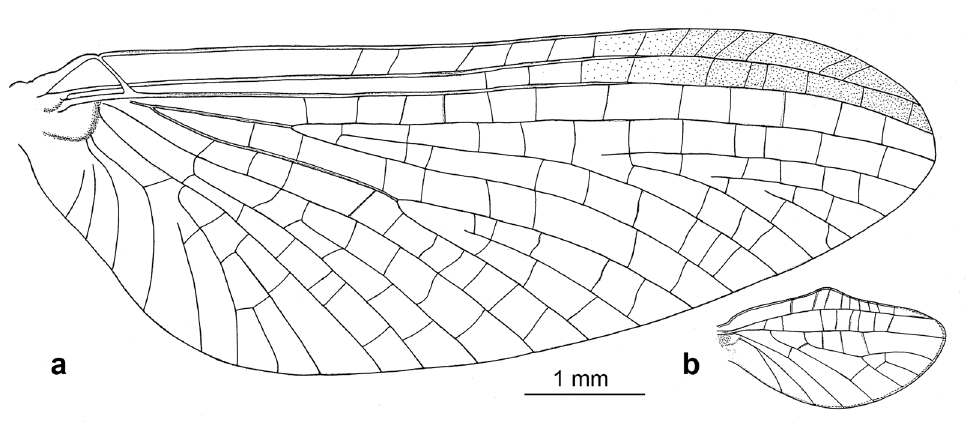
Figure 8. Calliarcys van Godunko & Bauernfeind, 2015 , male imago [Turkey; Soldán T. & Bojková J. coll.]: ( a ) forewing; ( b ) hind